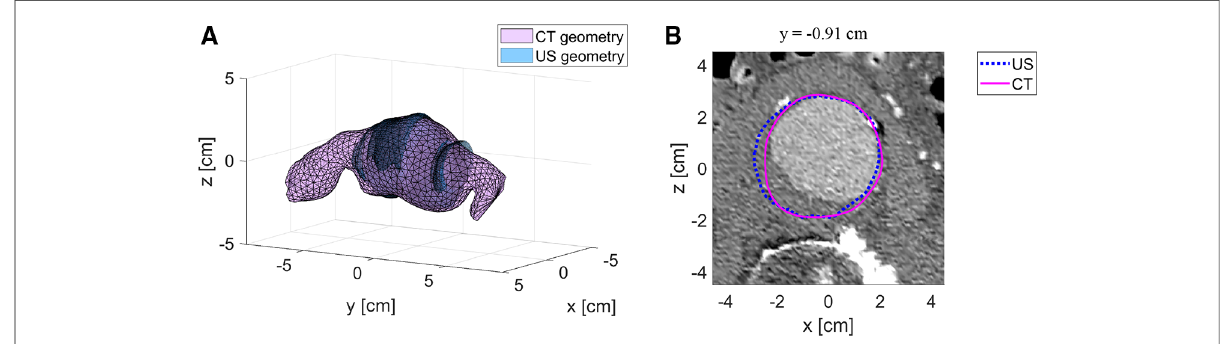
FIGURE 3 Example of registered US geometry with CT geometry. ( A ) US geometry of patient A2 (blue) with the corresponding CT geometry (purple) after registration. ( B ) Example of a CT image with the US contour (blue) and CT contour (purple) at location y = − 0.91